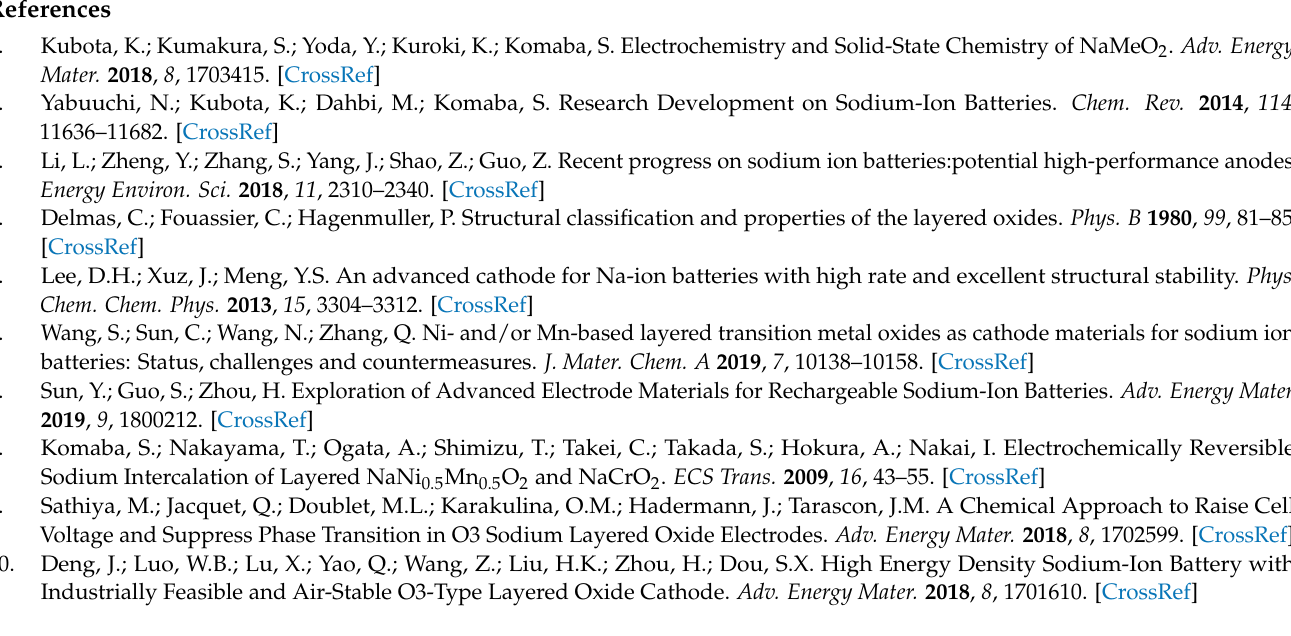
S2: Comparison between NMNO patterns obtained in different experimental conditions; Figure S3: Calculated models of the main O and P layered polymorphs, used to perform the Rietveld structural refinements described in the paper; Figure S4: XPRD patterns of NMNO-Ti before (black) and after (blue) air maintenance for some days; Figure S5: EDS spectrum; Figure S6: (A) Three cycles of